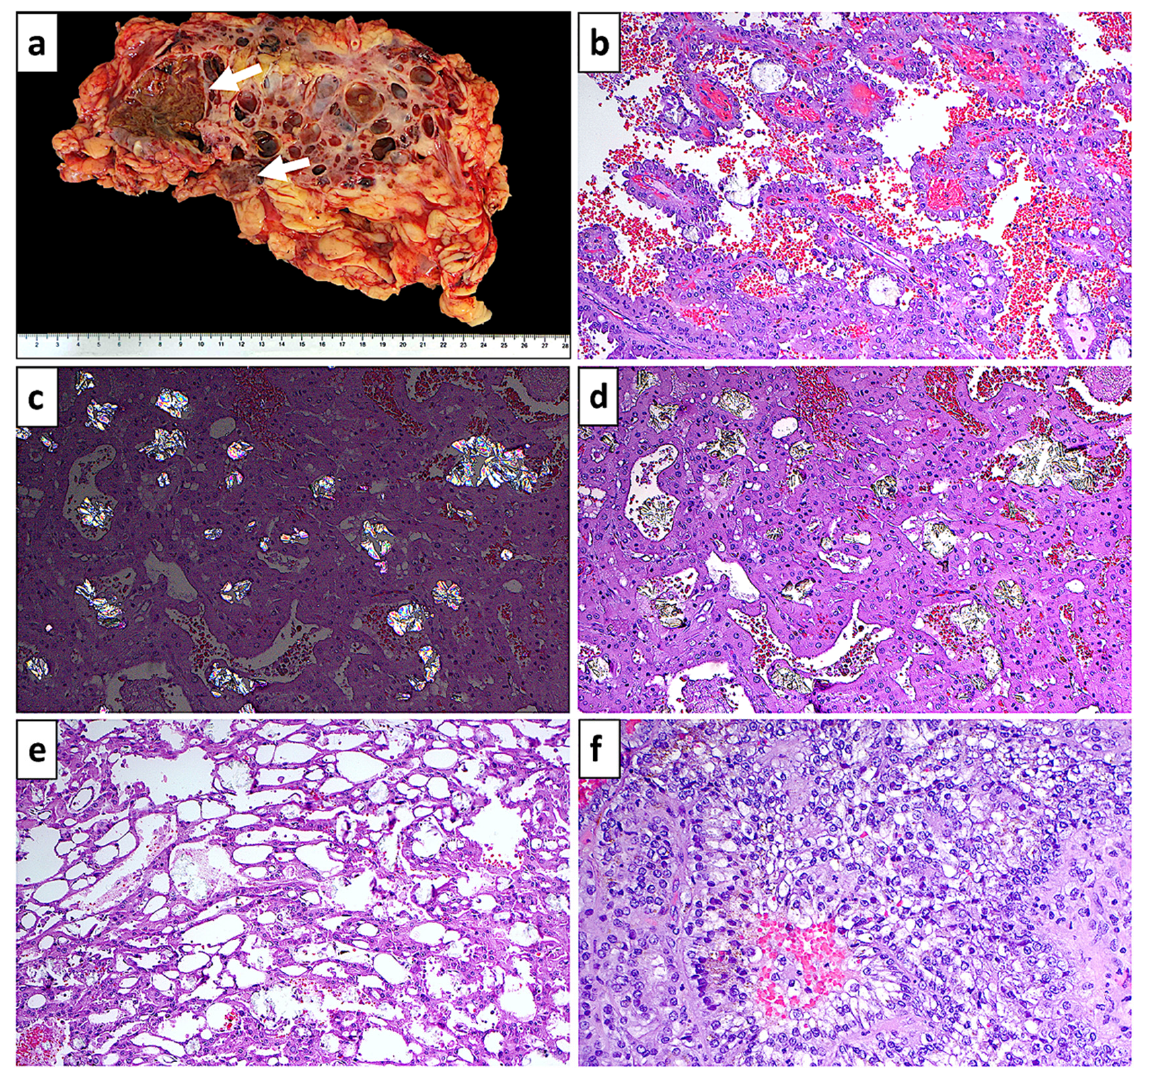
Figure 3. Gross and histological features of ACKD-RCC. ( a ) ACKD-RCC arising in two foci (arrows) of a kidney with multiple background cysts. ( b ) Papillary architecture in ACKD-RCC. ( c ) Calcium oxalate crystals in ACKD-RCC under polarized light. ( d ) Nests and cords of eosinophilic cells in ACKD-RCC with interspersed calcium oxalate. ( e ) Characteristic “sieve-like” spaces. ( f ) Area of an ACKD-RCC, including cells with clear cytoplasm. (Note: ( a ) gross image, ( b – f ) photomicrographs of hematoxylin and eosin stained sections, ( b – e ) 100× magnification, ( f ) 200× magnification).